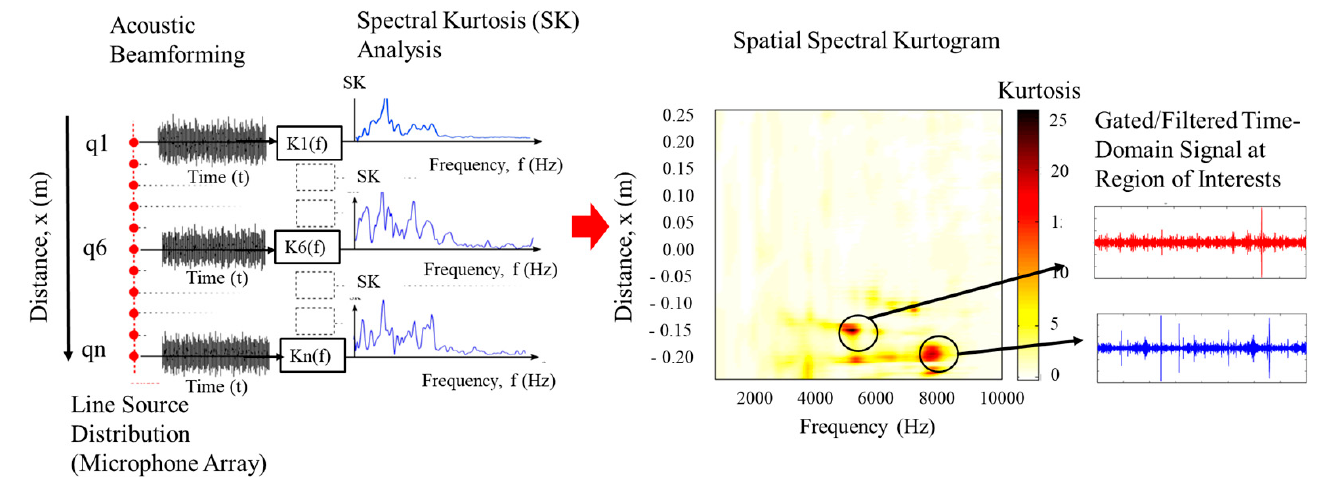
Figure 20. Application of spectral kurtosis to acoustic beamforming for machine fault diagnosis [85,86].